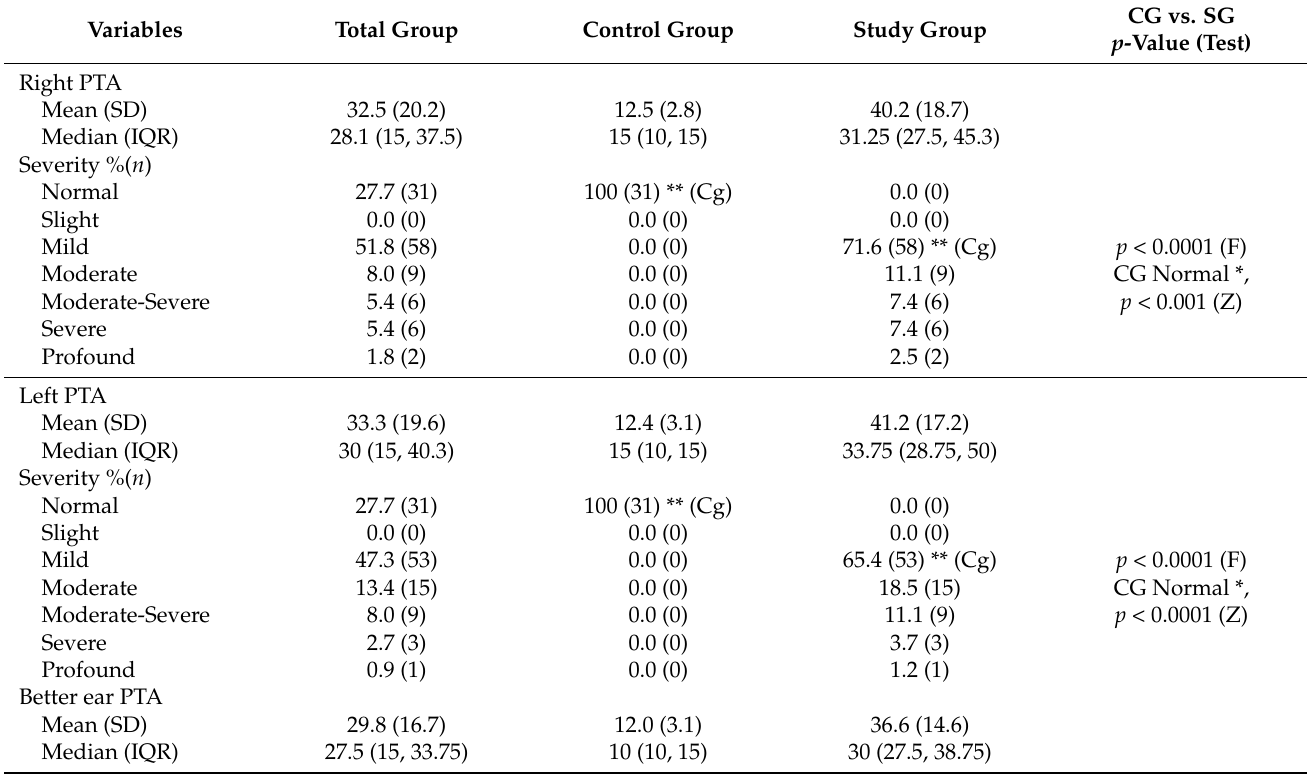
Table 2. Hearing threshold in the study group and control